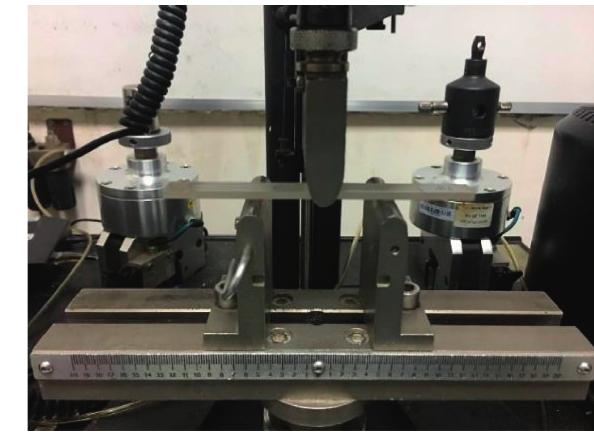
Figure 4: Sample mounted on the Instron 5566